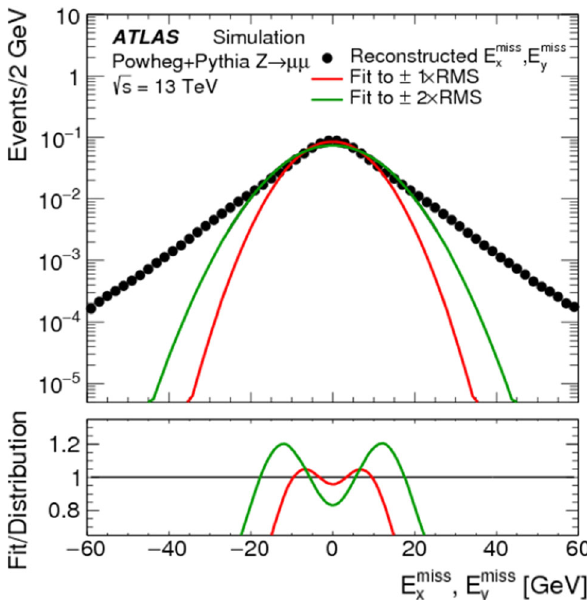
the widths measured by fitting Gauss functions in selected ranges of the